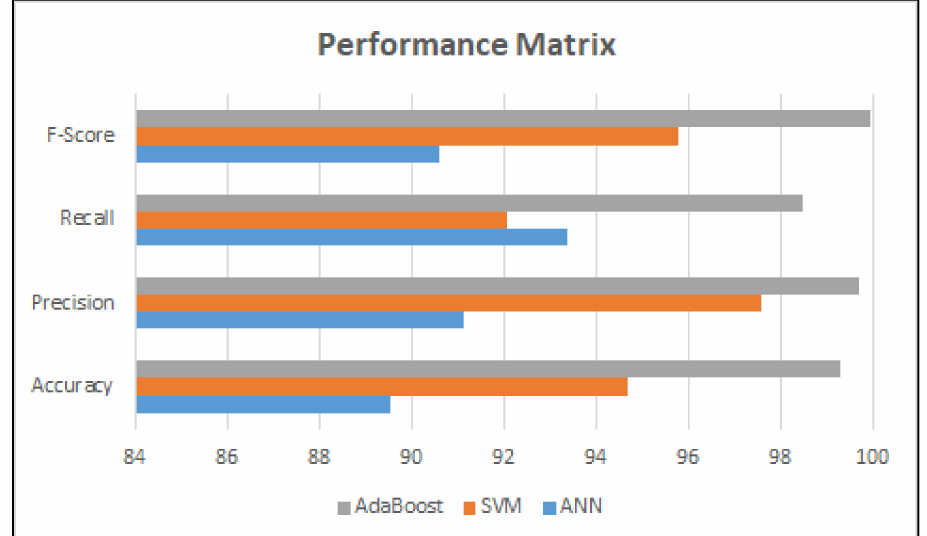
Figure 4. Performance matrix based on different